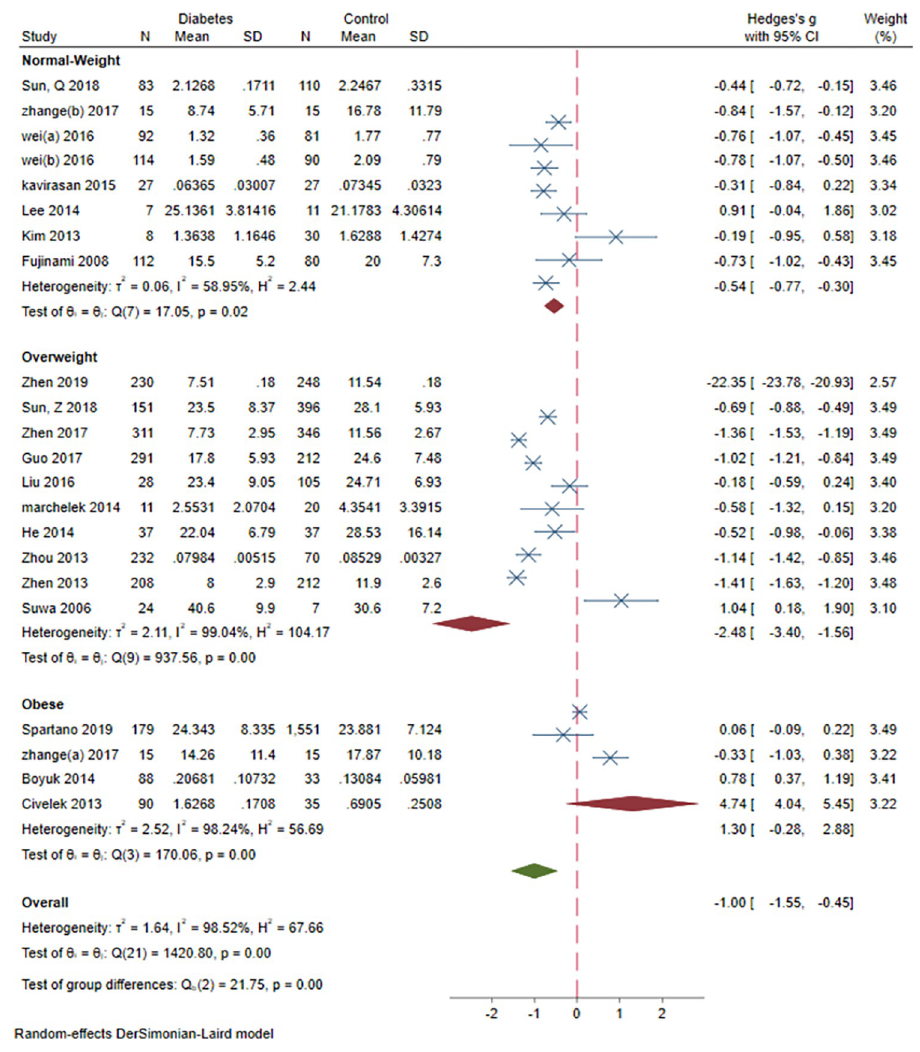
Fig 14. Subgroup meta-analysis of BDNF levels in patients with DM by BMI-based weight status.